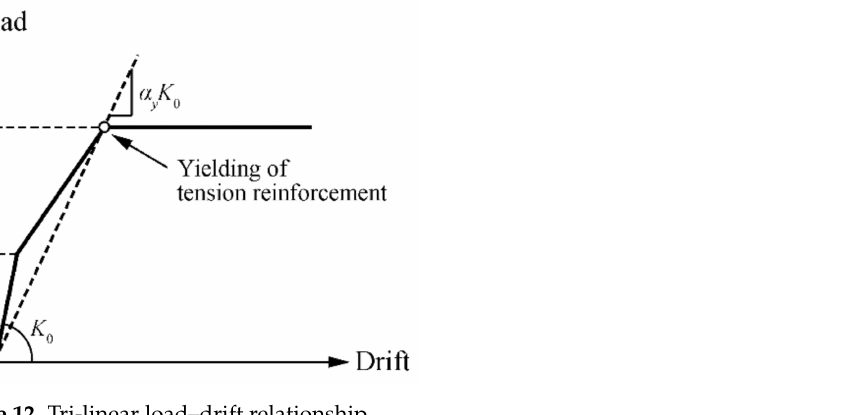
Figure 12. Tri-linear load–drift relationship.